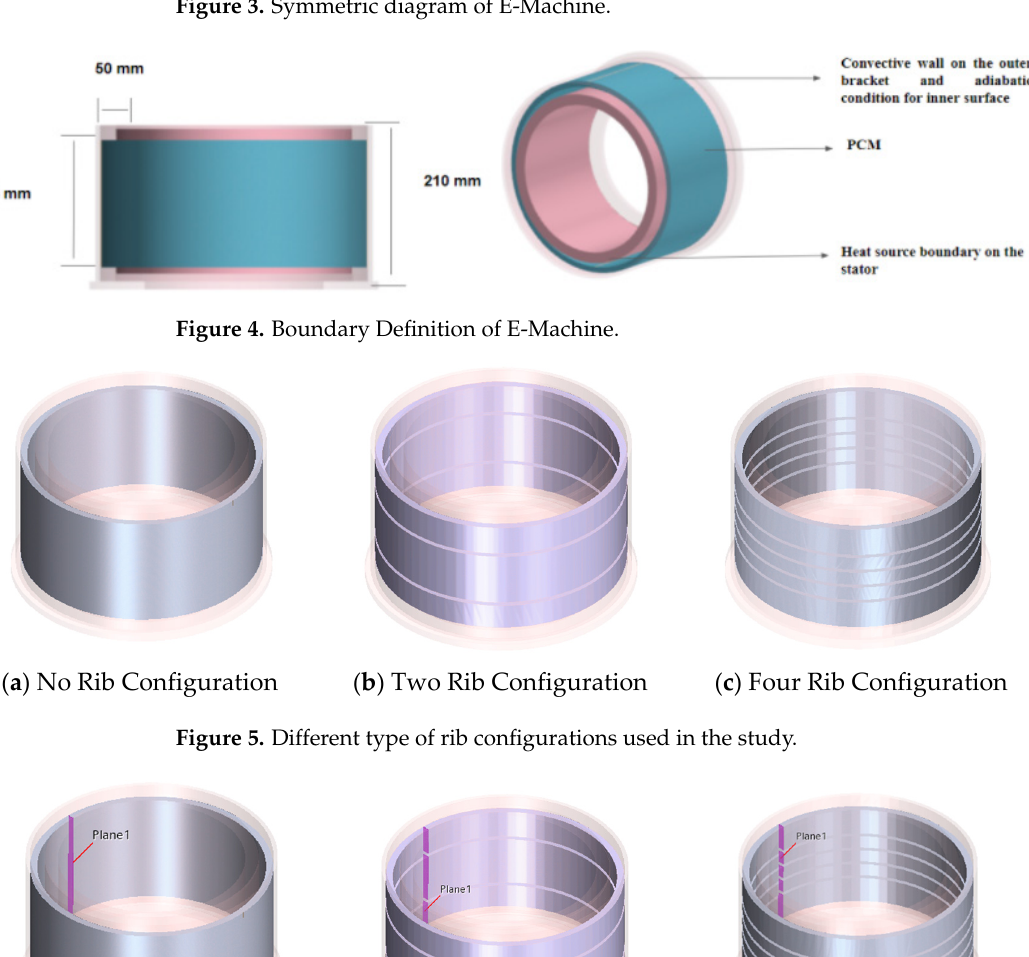
Figure 5. Different type of rib configurations used in the study.